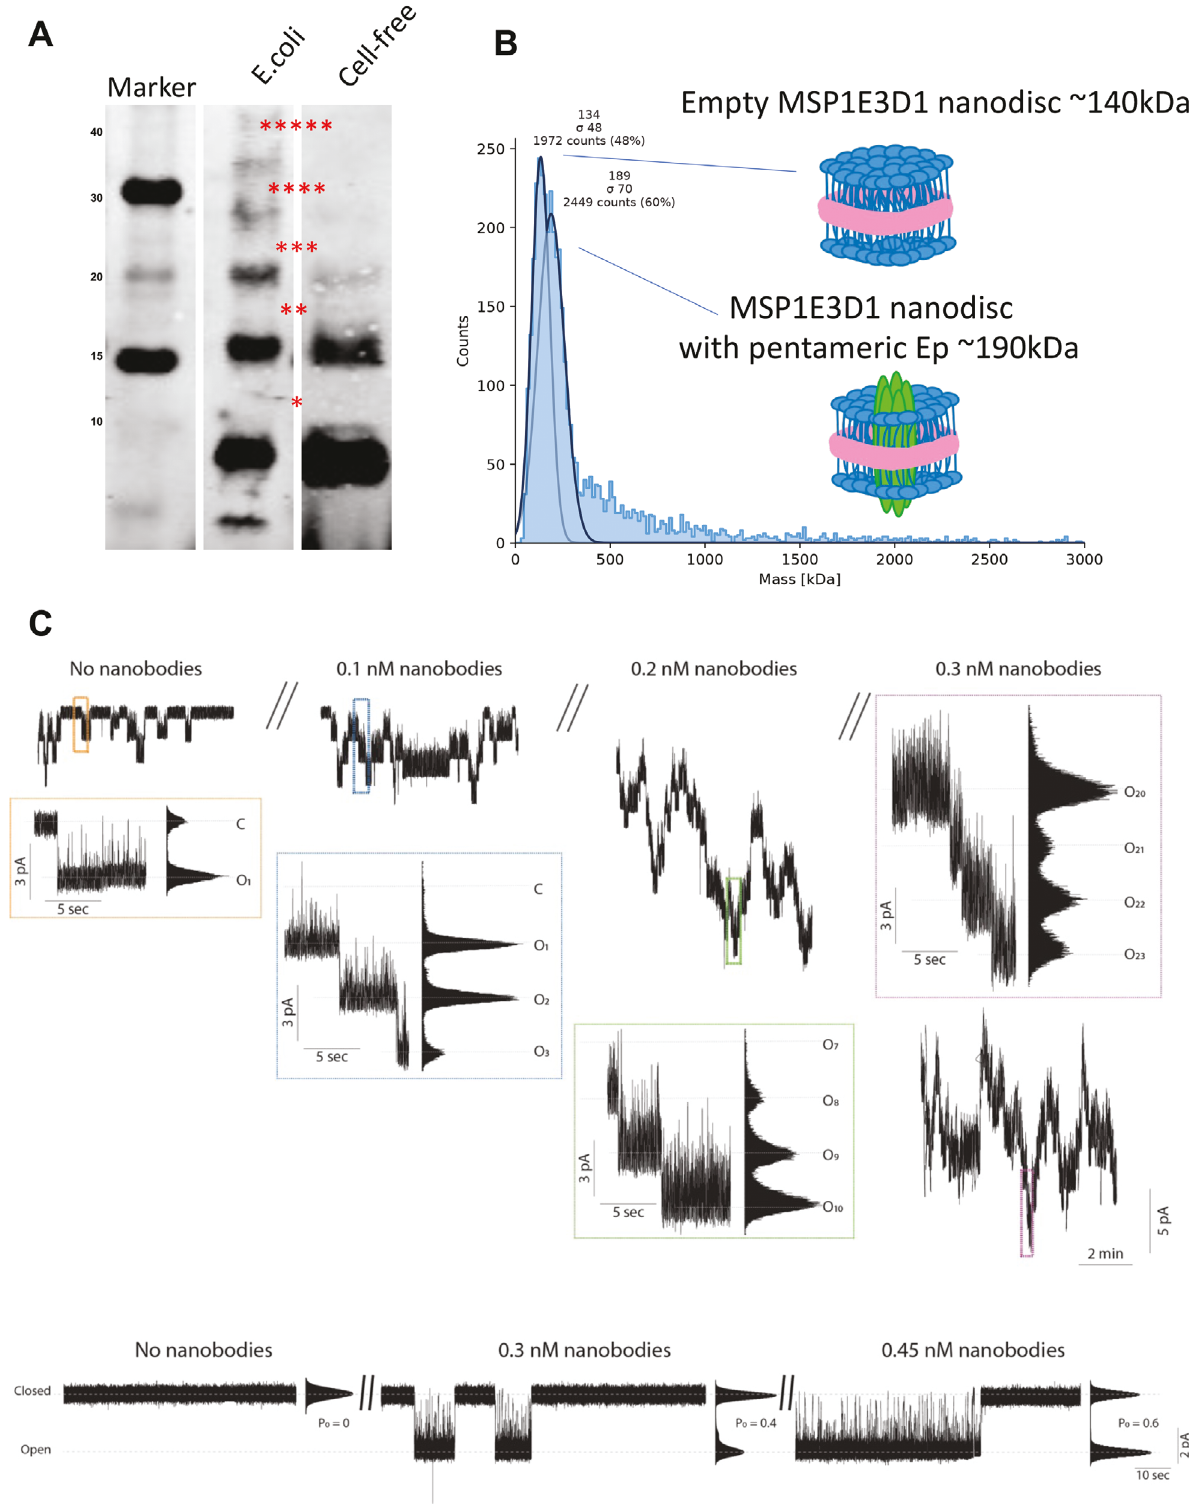
Fig. 4 Effects of nanobody binding to soluble regions of SARS-CoV-2 E-protein. A , B Pentameric E-protein for ion channel recordings is produced using cell-free expression in the presence of lipid nano-discs and mass photometry showing pentameric SARS-CoV-2 E protein embedded in the lipid nano-disc membrane. Samples with cell-free protein production without SARS-CoV-2 E protein (no-vector) were tested on suspended membranes as a control for pore- or channel-forming contaminations. C Upper panel, multi-channel recordings at 0, 0.1, 0.2 and 0.3 nM nanobodies. Lower panel, single-channel recordings of E protein at nanobody concentration of 0.3 and 0.45 nM. Recordings were done in symmetrical buffer conditions using 250 mM KCl, 1 mM EGTA, and 10 mM HEPES, pH 7.4/KOH. Data were low-pass fi ltered with a 10 kHz Bessel fi lter and sampled at 100 kHz. After digitization, data were additionally fi ltered to achieve satisfactory signal-to-noise ratio using a digital Bessel fi lter at 0.1 kHz. Cell Death and Disease (2023)